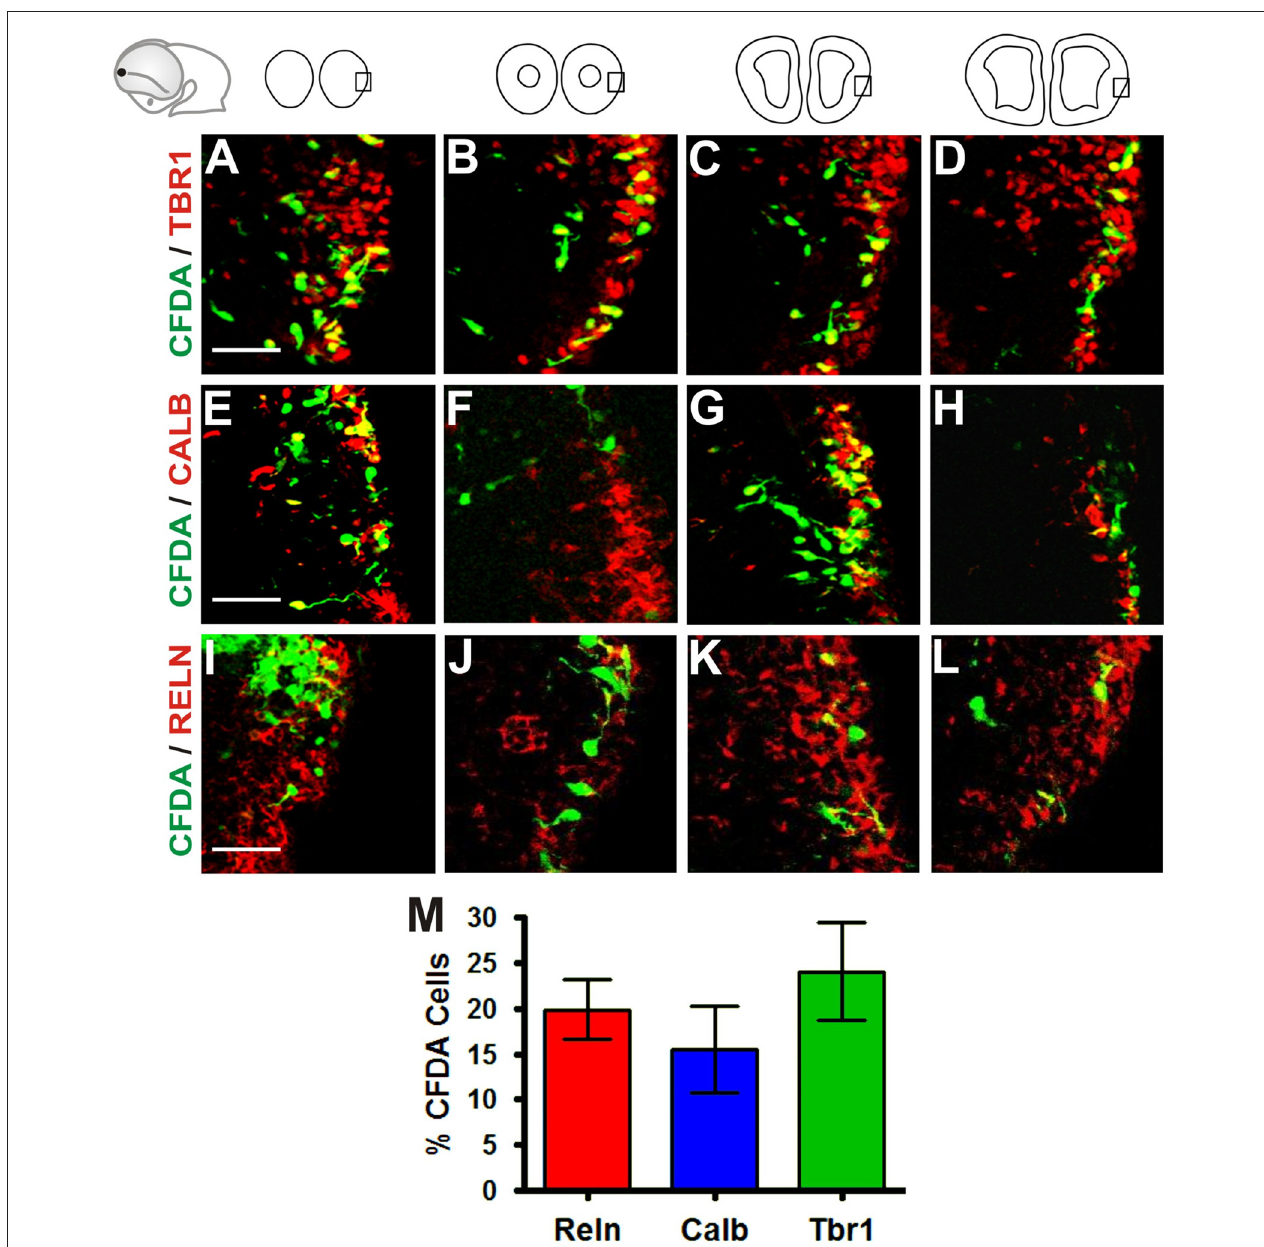
FIGURE 2 | Neurons generated in the Rld correspond to various cell populations. Immunostaining of telencephalic coronal sections from a representative CFDA-labeled embryo (E10.5 + 24 h in culture) with antibodies against different markers. (A–D) Pallial marker Tbr1. (E–H) Subpallial marker Calbindin. (I–L) Reelin, marker of Cajal-Retzius (CR) cells. (M) Proportions of CFDA-labeled neurons positioned in the MZ near to the piriform cortex: approximately 24% are Tbr1 + , 15.5% are Calbindin + and 19.8% are Reelin + . Scale bar: 50 µ m.